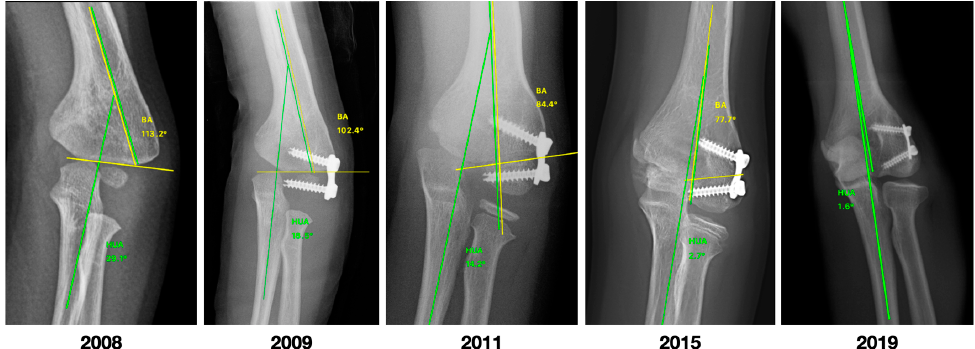
Figure 5. ( A , B ) Preoperative clinical images of a patient from the study in which the cubitus varus and hyperextension deformity can be seen. ( C , D ) 7-year postoperative clinical images of the same patient in which an improvement of the arm axis can be seen.